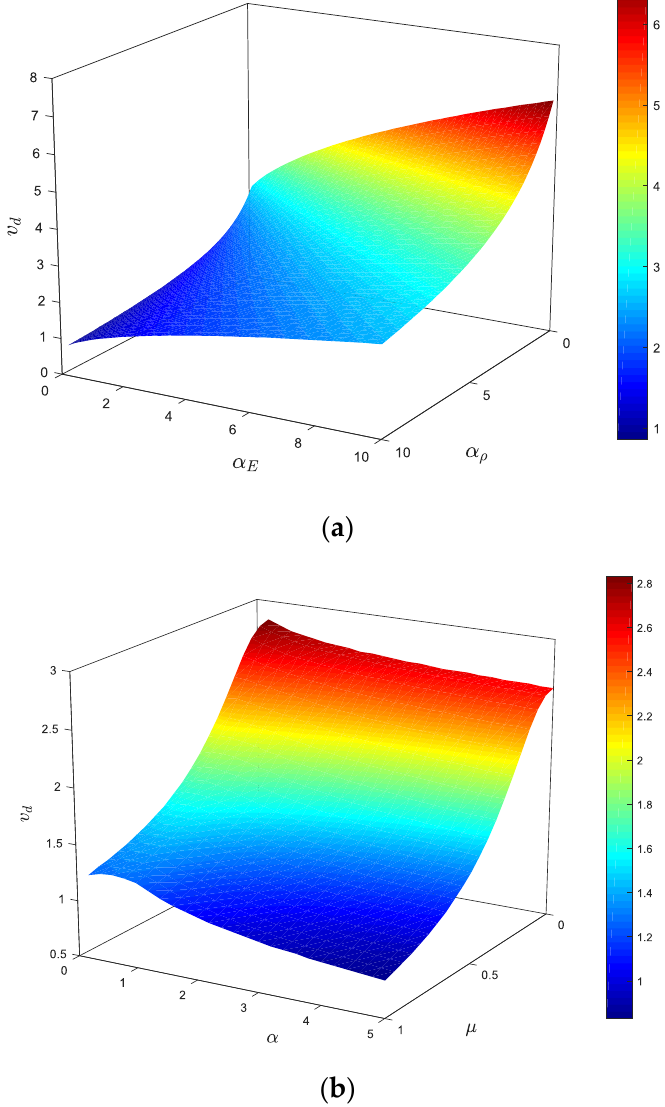
Figure 12. Combined effect of ( a ) density and elastic modulus gradient parameters and ( b ) nonlocal and gradient parameters on the critical velocity for ζ = 0, k f = 0.5, k = 1.